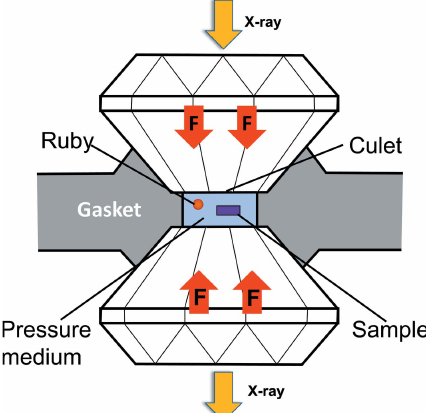
Figure 12 High-pressure setup using diamond anvil cells (DACs) to submit samples to extreme conditions. The focused X-ray beam goes through the two diamond cells that are loaded against each other through a gasket to create a closed environment with pressures reaching several tens to hundreds of GPa. A pressure medium is used to distribute the pressure and a ruby sphere is used as a pressure gauge via an optical signal. Culet sizes are typically of the order of a few hundred micrometres.